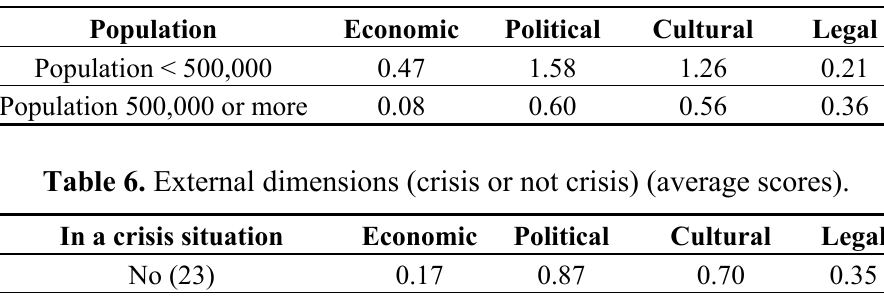
Table 5. External dimensions, by geographic area (average scores).